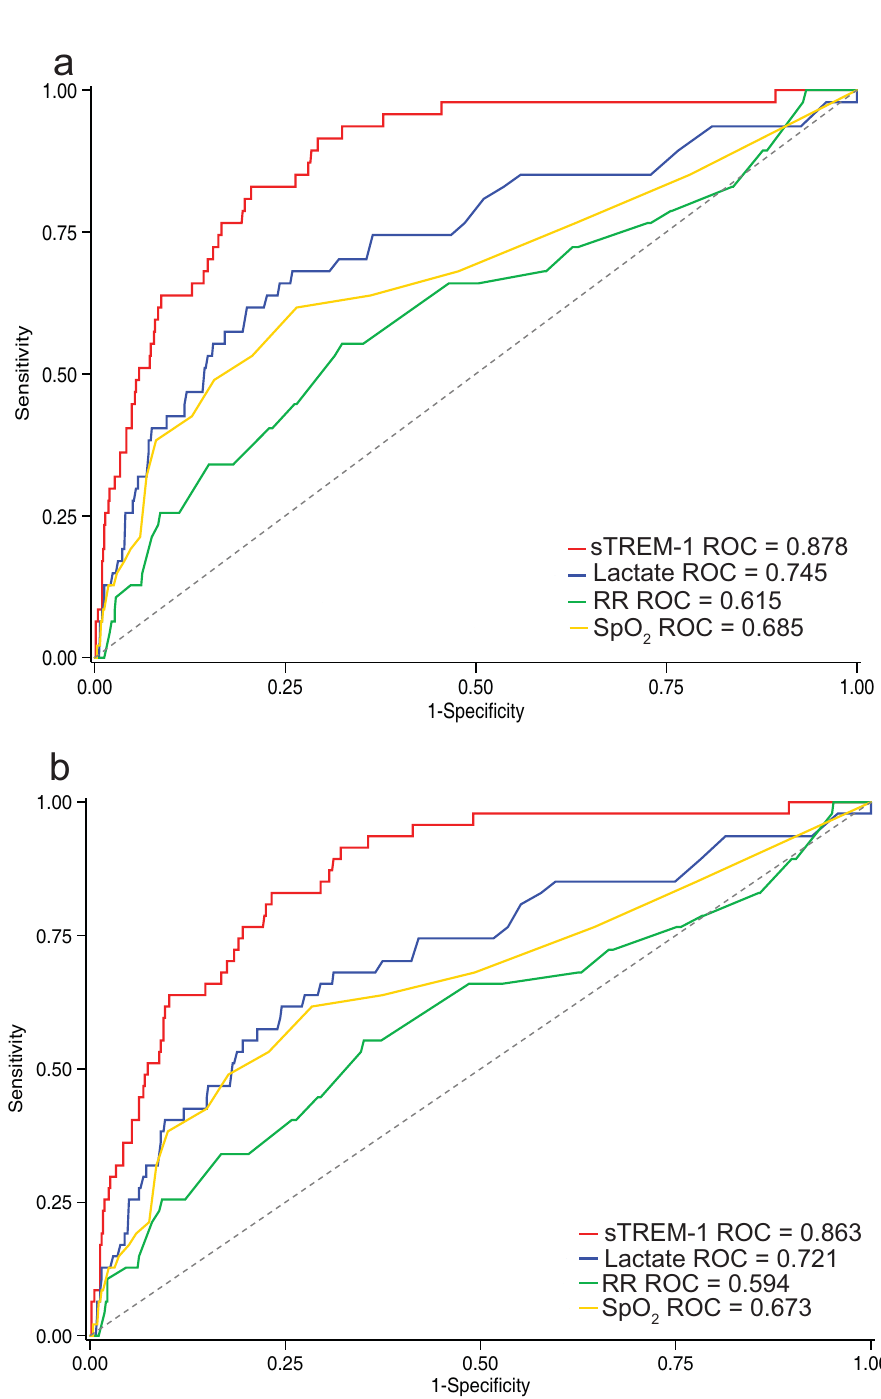
Fig 2. ROCs for predicting 48-hour in-hospital mortality using sTREM-1 versus common clinical parameters. (a) sTREM-1 (AUROC 0.878 95% CI 0.832–0.924) compared with lactate (AUROC 0.745, 95% CI 0.664–0.826, P < 0.001), RR (AUROC 0.615, 95% CI 0.528–0.702, P < 0.001), and oxygen saturation by pulse oximetry (SpO 2 ) (AUROC 0.685, 95% CI 0.594–0.776, P = 0.002) in cases of IMCI pneumonia and (b) sTREM-1 (AUROC 0.863, 95% CI 0.814–0.911) compared with lactate (AUROC 0.721, 95% CI 0.638–0.803, P < 0.001), RR (AUROC 0.594, 95% CI 0.505–0.684, P < 0.001), and SpO 2 (AUROC 0.673, 95% CI 0.582–0.764, P = 0.002) in cases of severe